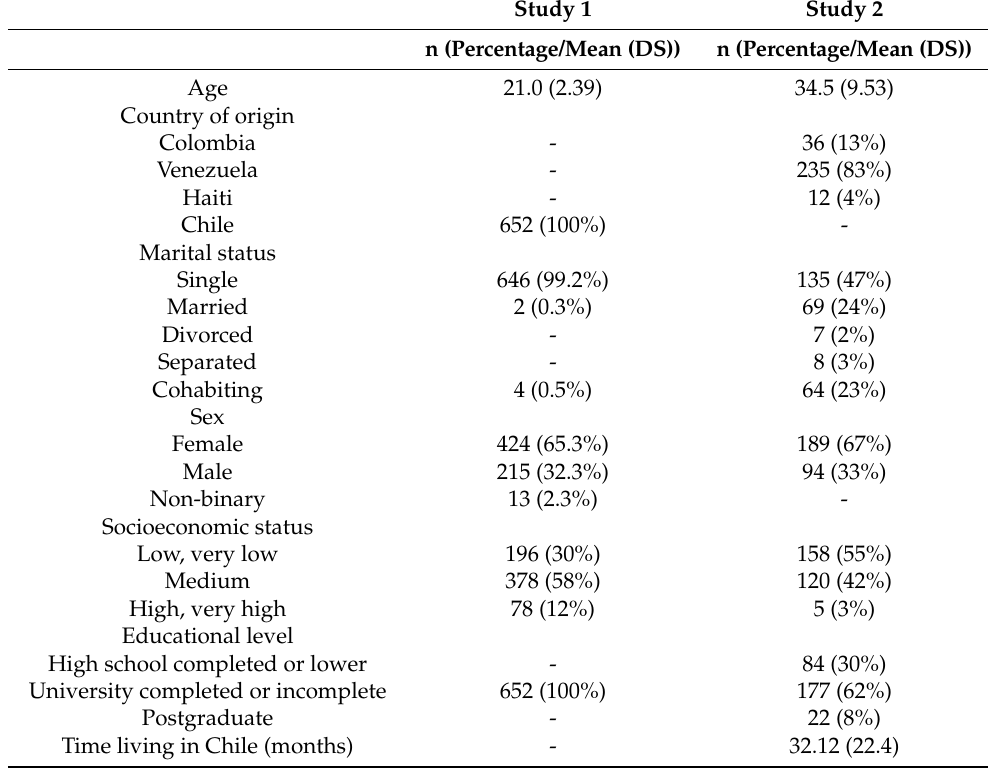
Table 2. Sociodemographic descriptions of the sample (emerging adults and international